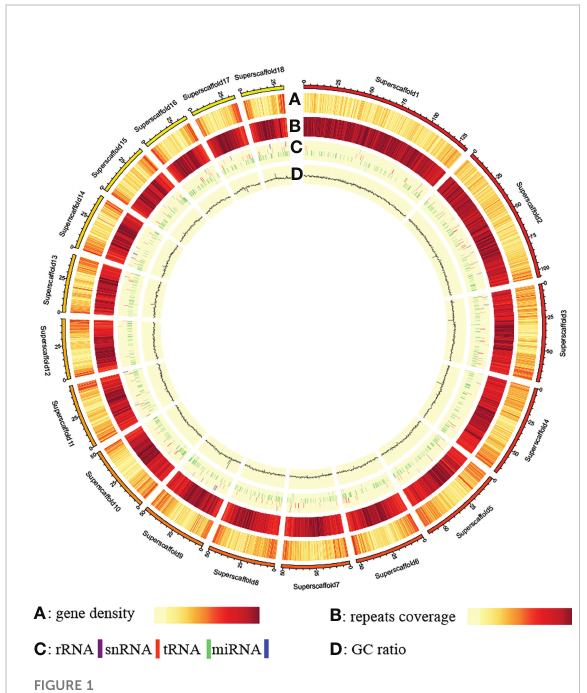
FIGURE 1 Distribution pattern of annotated elements along the